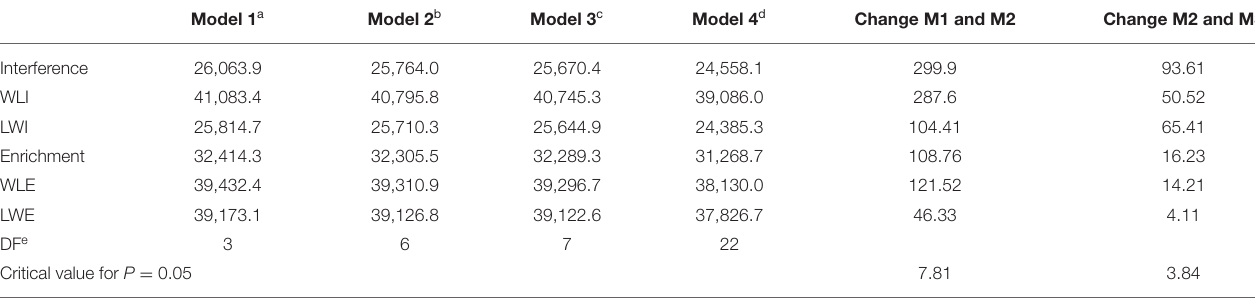
a Unconditional mean model. b Unconditional linear growth curve model. c Unconditional Quadratic linear growth curve model. d Conditional Quadratic linear growth curve model (model adjusted for covariates). e Degrees of